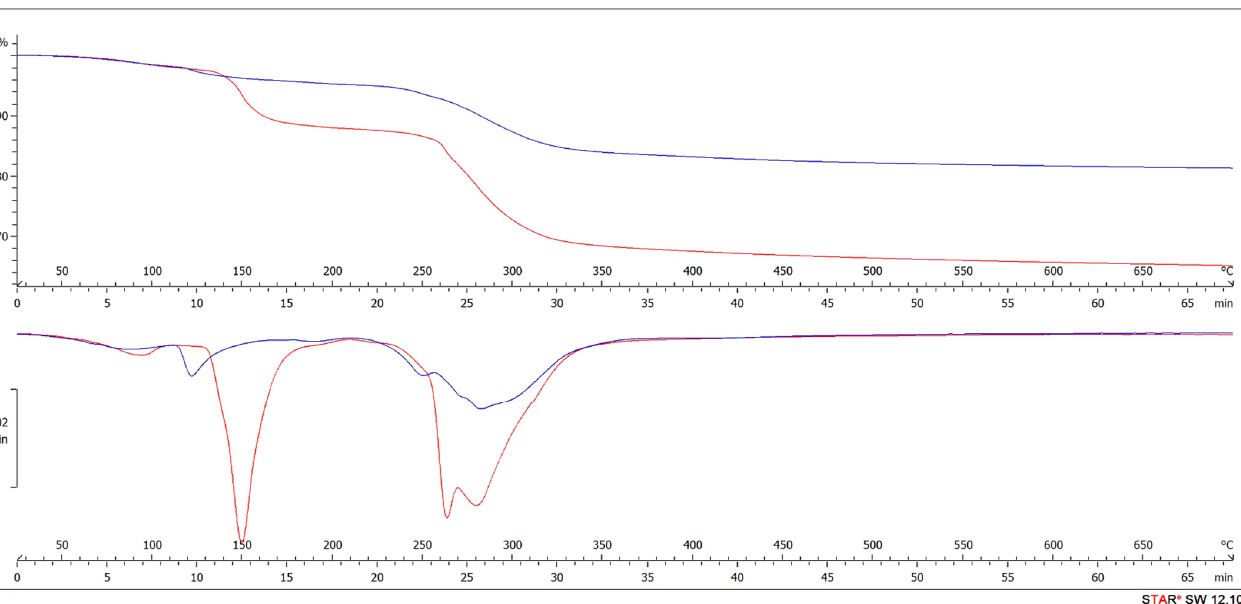
Figure 4. Thermal gravimetric analysis (TGA) curves ( top ) and derivative thermogravimetry (DTG) curves ( bottom ) of Ref10 (red) and BB15 (blue).